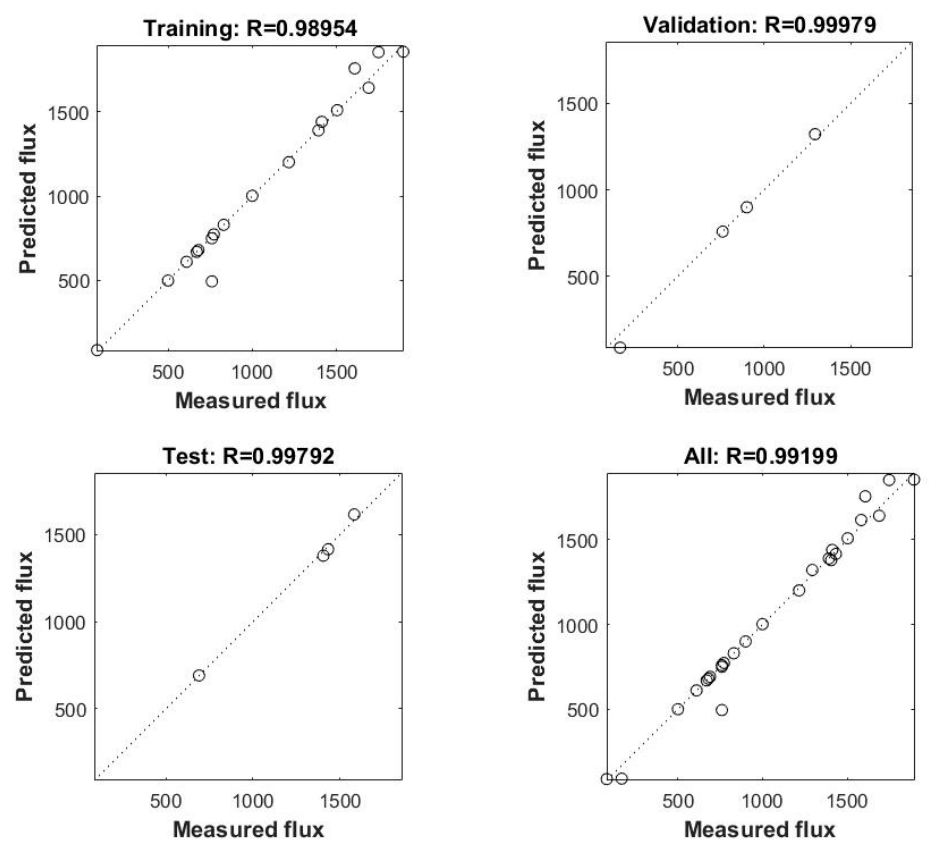
Figure 4. Network training and regression plots for the prediction of nitrous oxide emissions.